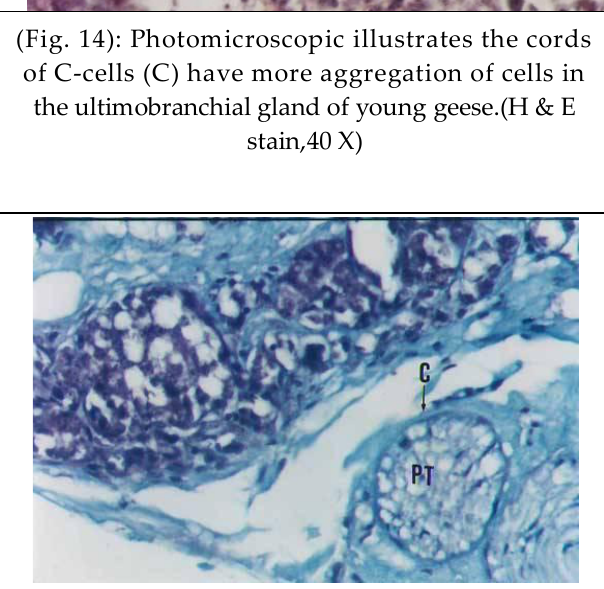
(Fig.17): Photomicroscopic illustrates the stroma in ultimobranchial gland of adult geese containing vesicles (V) various in numbers, shapes and sizes and almost of these vesicles are empty and invaded by nerve fibers (N). ( H&E stain , 40X )